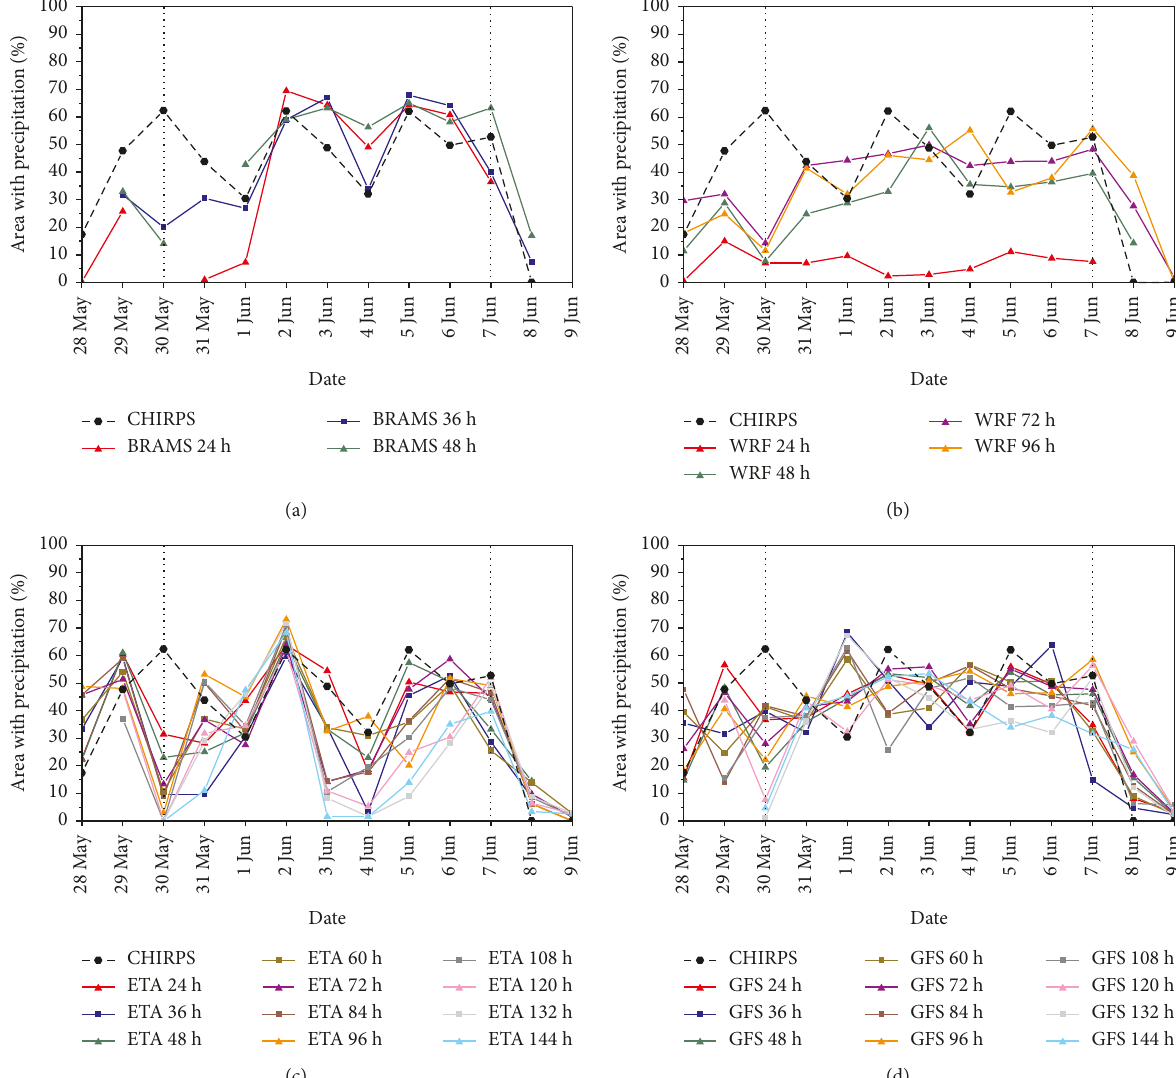
1 (%) for CHIRPS day · −